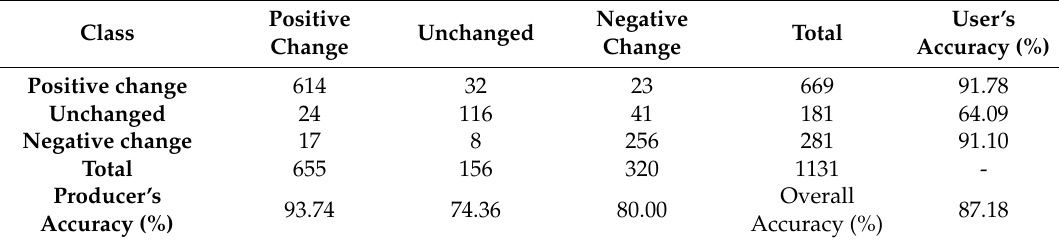
Table 4. Trend detection